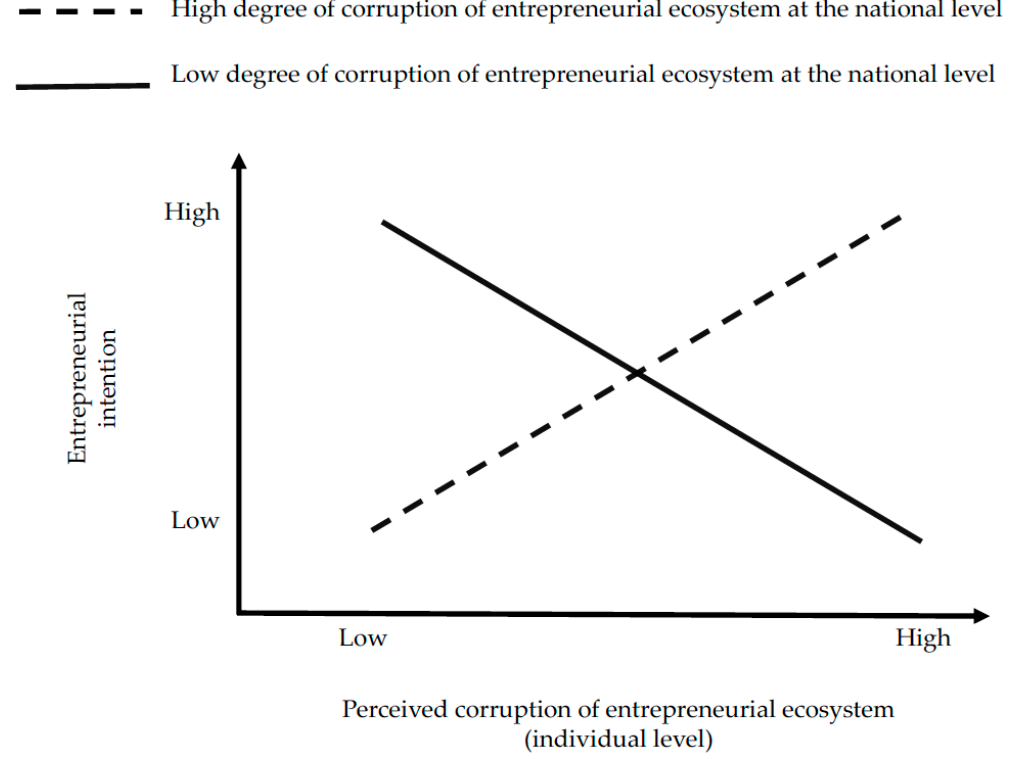
Figure 1. Graphical representation of Proposition 3.